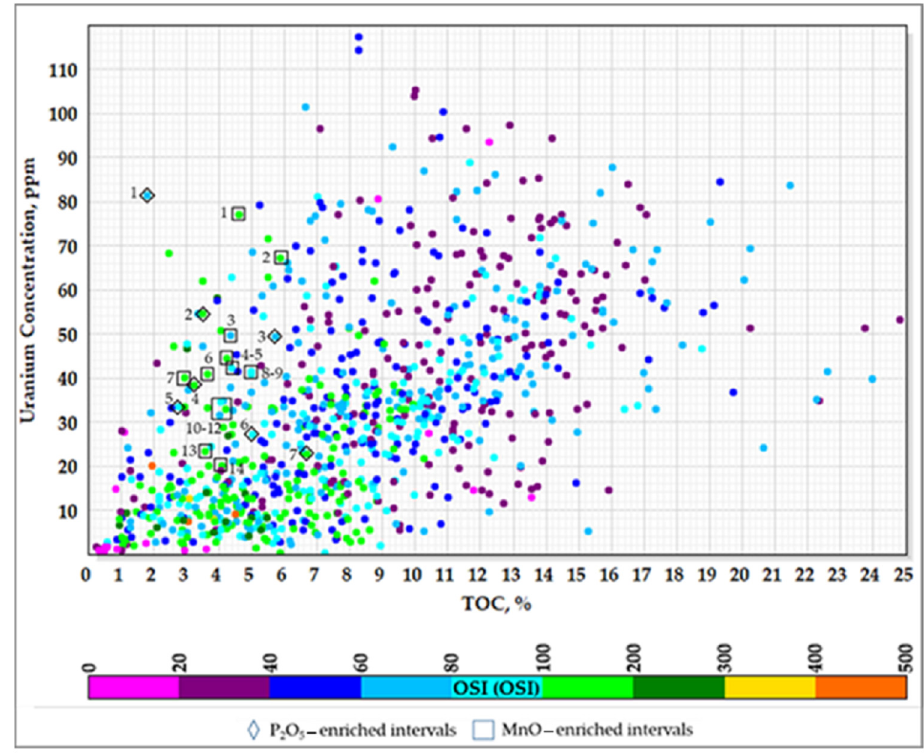
Figure 10. Cross-plot of the uranium concentration and total organic carbon (TOC) according to the study of 12 wells penetrating the BF. The color of the dots reflects the oil saturation index (OSI) values.